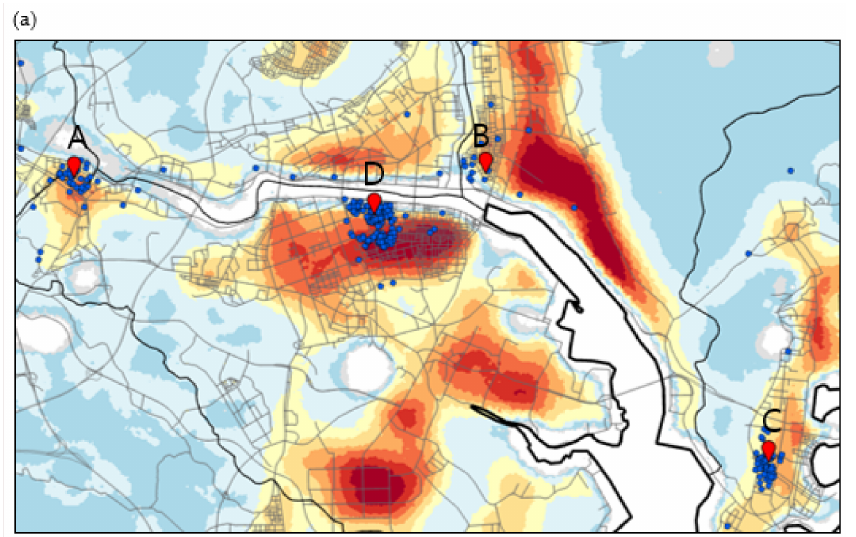
Figure A1. Night-time noise level throughout the study year by each school. ( A ) Gulhwa represents the coastal environment; ( B ) Myeongchon represents the residential area; ( C ) Yangji represents the industrial area; ( D ) Samshin represents the downtown area. Most noise levels of the 4 schools exceeded the night noise limit around the residential area. The overall levels show a decreasing trend. The red dotted lines shows noise limit levels established under various noise regulations. According to the 58dB Enforcement Rules of the Noise and Vibration Control Act, the management standards for road traffic noise and vibration for residential areas at night is 58 dB(A); According to the Framework Act on Environmental Policy, the night noise standard for residential areas is 40 dB(A), and that of commercial areas is 55 dB(A); The diamond symbol of the graph is the noise estimates.